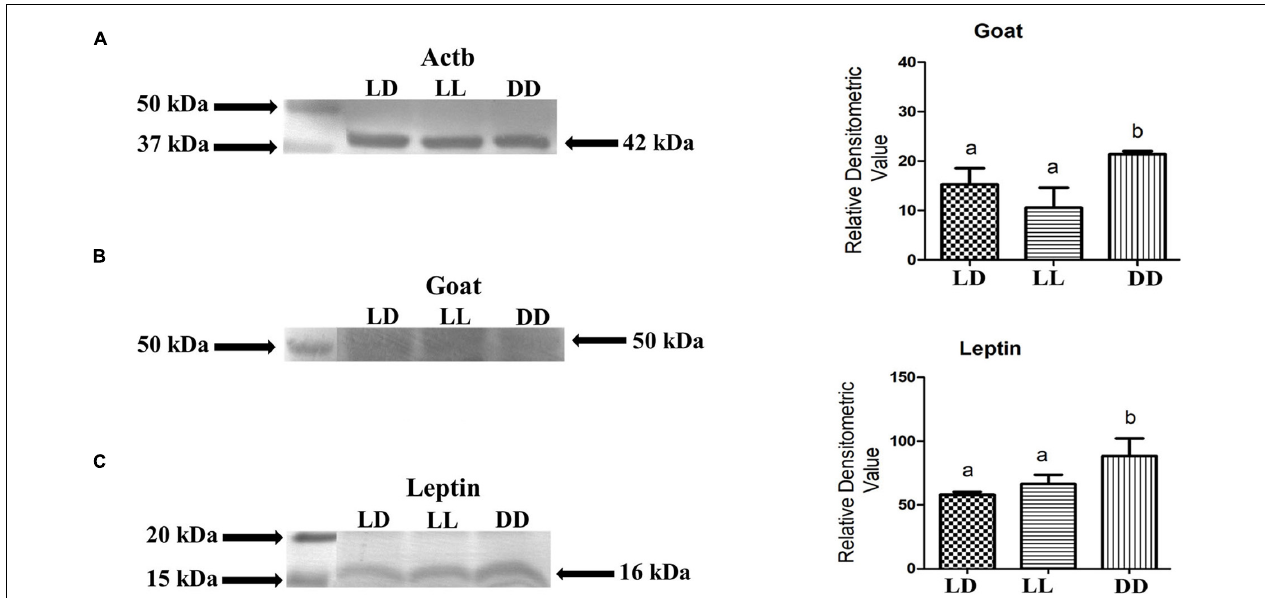
FIGURE 6 | Leptin and Goat proteins are expressed in zebrafish brain and are affected by different photic conditions. Representative immunoblot shows bands representing Actb corresponding to 42 kDa (A) , Goat corresponding to 50 kDa (B) and Leptin corresponding to 16 kDa (C) . Average relative protein expression levels from five zebrafish brain from each experimental condition were analyzed by densitometry analysis. One-way ANOVA [ (B) F (2,6) = 32.327, p = 0.001, (C) F (2,6) = 60.216, p = 0.000] followed by post-hoc Tukey’s test has been done for statistically significant relative quantification. Groups sharing a common letter show no significant difference ( p < 0.05; n = 5